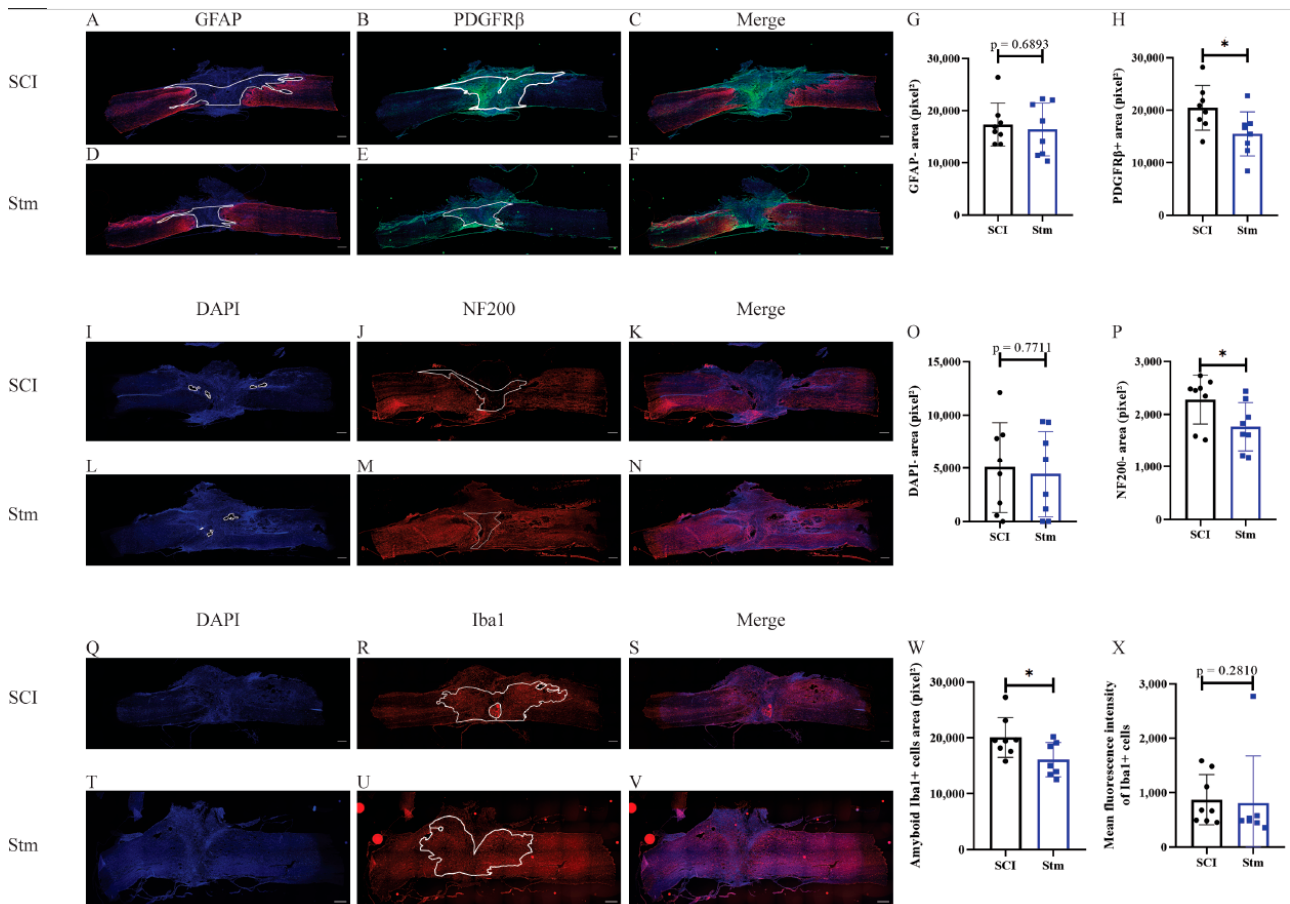
Figure 3. rTSMS treatment enhances tissue repair after a complete transection of the spinal cord 15 days after SCI in rats. At day 15, immunohistological analyses were performed. ( A – F , I – N , Q – T , U , V ) Representative pictures of sagittal spinal cord sections of ( A – C , I – K , Q – S ) SCI and ( D – F , L – N , T – V ) Stm (rTSMS treated) animals. Sections were stained with ( A , D ) GFAP, ( B , E ) PDGFR β , ( I , L , Q , T ) DAPI, ( J , M ) NF200 and ( R , U ) Iba1. ( G ) Quantification of astrocytic-negative area (GFAP-). ( H ) Quantification of fibrosis-positive area (PDGFR β +). ( O ) Quantification of DAPI-negative area (DAPI-). ( P ) Quantification of NF200-negative area (NF200-). ( W ) Quantification of Iba1-amyboid-positive cells’ area (Iba1+) and ( X ) quantification of Iba1+ mean fluorescence intensity. Scale bars are 200 μ m; n = 8 animals per group. Quantifications are expressed as average ± SD. Statistical evaluations are based on the Mann–Whitney test (* = p < 0.05).